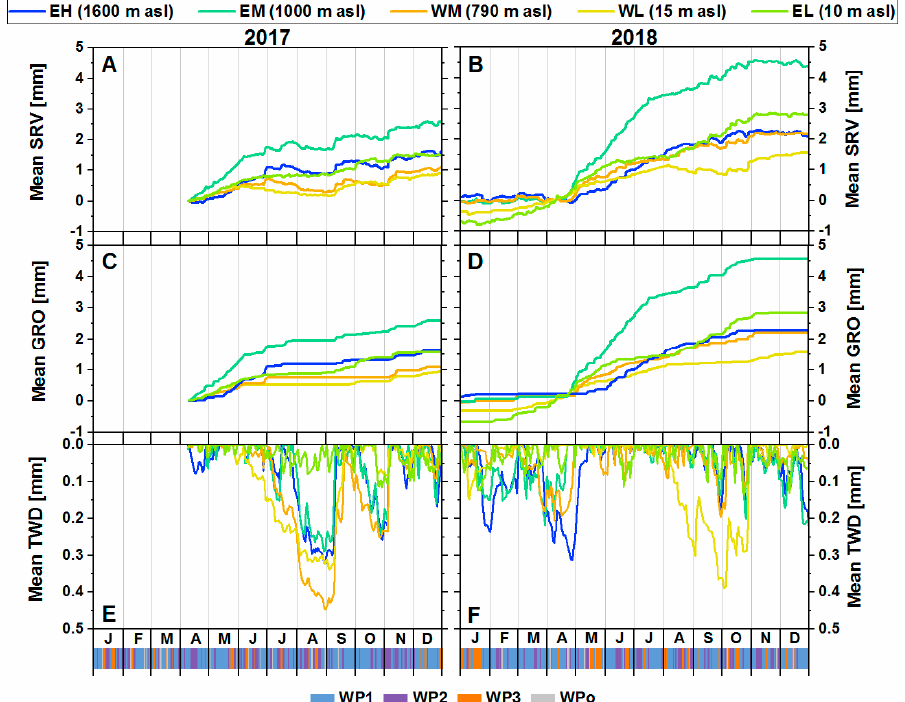
Figure 2. Daily stem radial variations (SRV) expressed as mean values from 5–11 trees per site in 2017 and 2018 ( A , B ). Site averages for mean irreversible growth (GRO) and tree water deficit (TWD) for 2017 and 2018 ( C – F ). Values in panels A–D were set to 0 at DOY 99. Bars at the bottom of the graph show daily prevalent weather patterns (see Section 3.2) of the western Mediterranean. The smallest difference between the two contrasting years was observed at site EH (+39% in 2018), and the largest difference was at site WM (+104% in 2018, Table 1). At site EH, mean daily growth rates were higher in 2017 than in 2018 until July, whereas the two mid-elevation sites only had higher daily growth rates in 2017 until April (see Supplementary Figure S2). The differences between the two investigated years were significant (paired t-test [44], p = 0.05, Table S1) for each site, where data of 2018 were cropped to DOY 99–365 for comparisons with